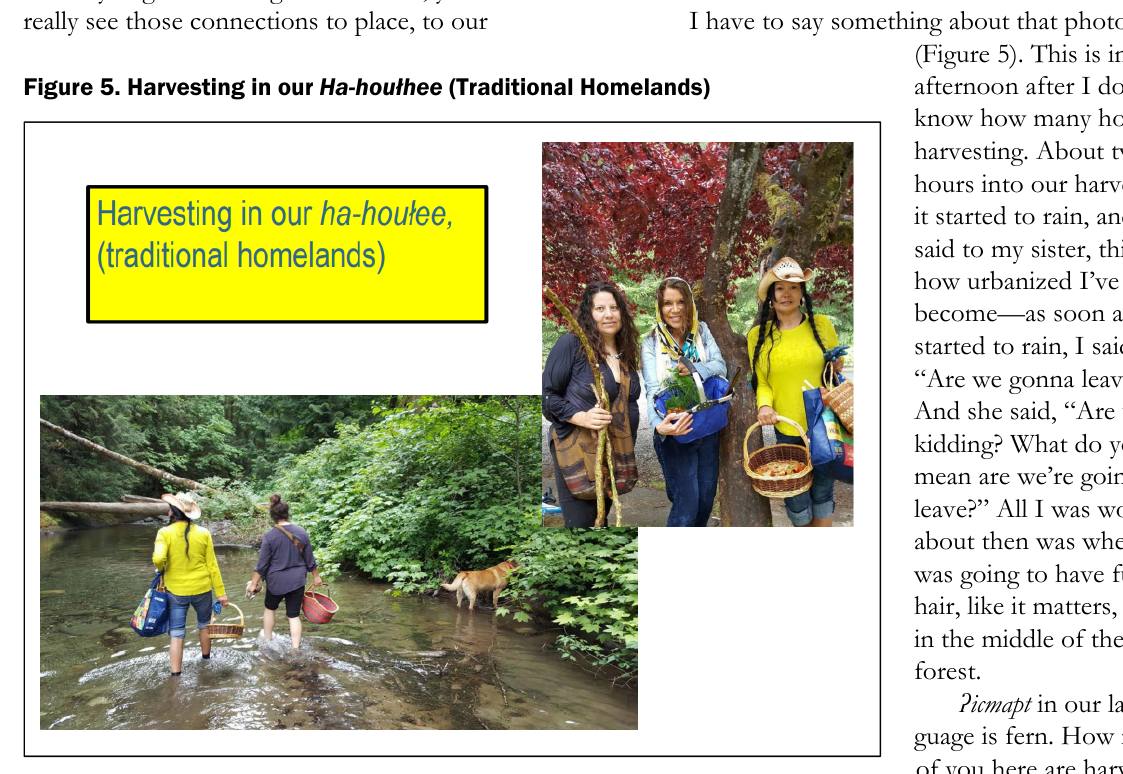
Figure 6. Harvesting ʔ icmapt Fern and Fern